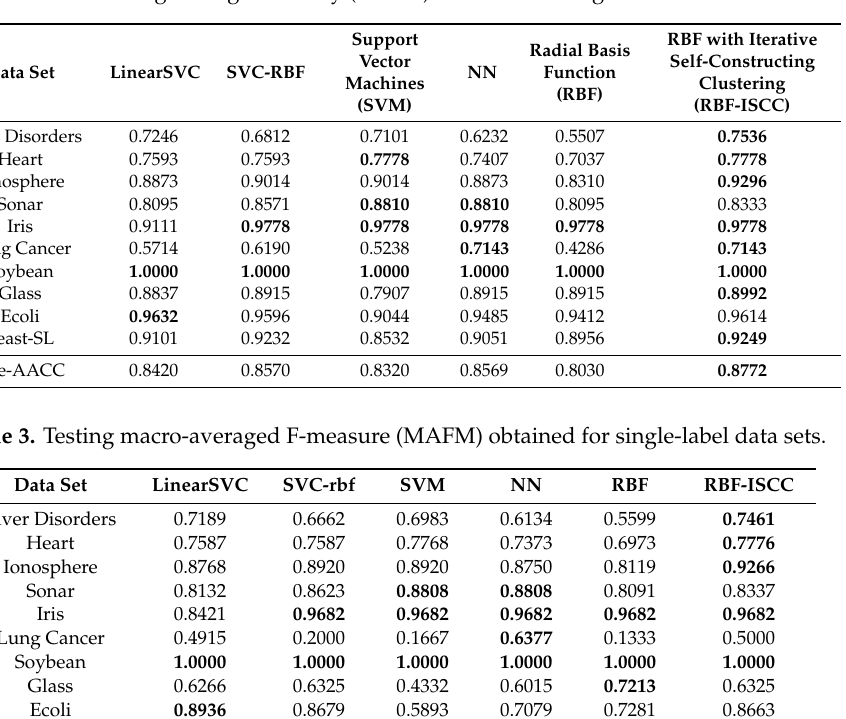
Table 2. Testing average accuracy (AACC) obtained for single-label data sets.